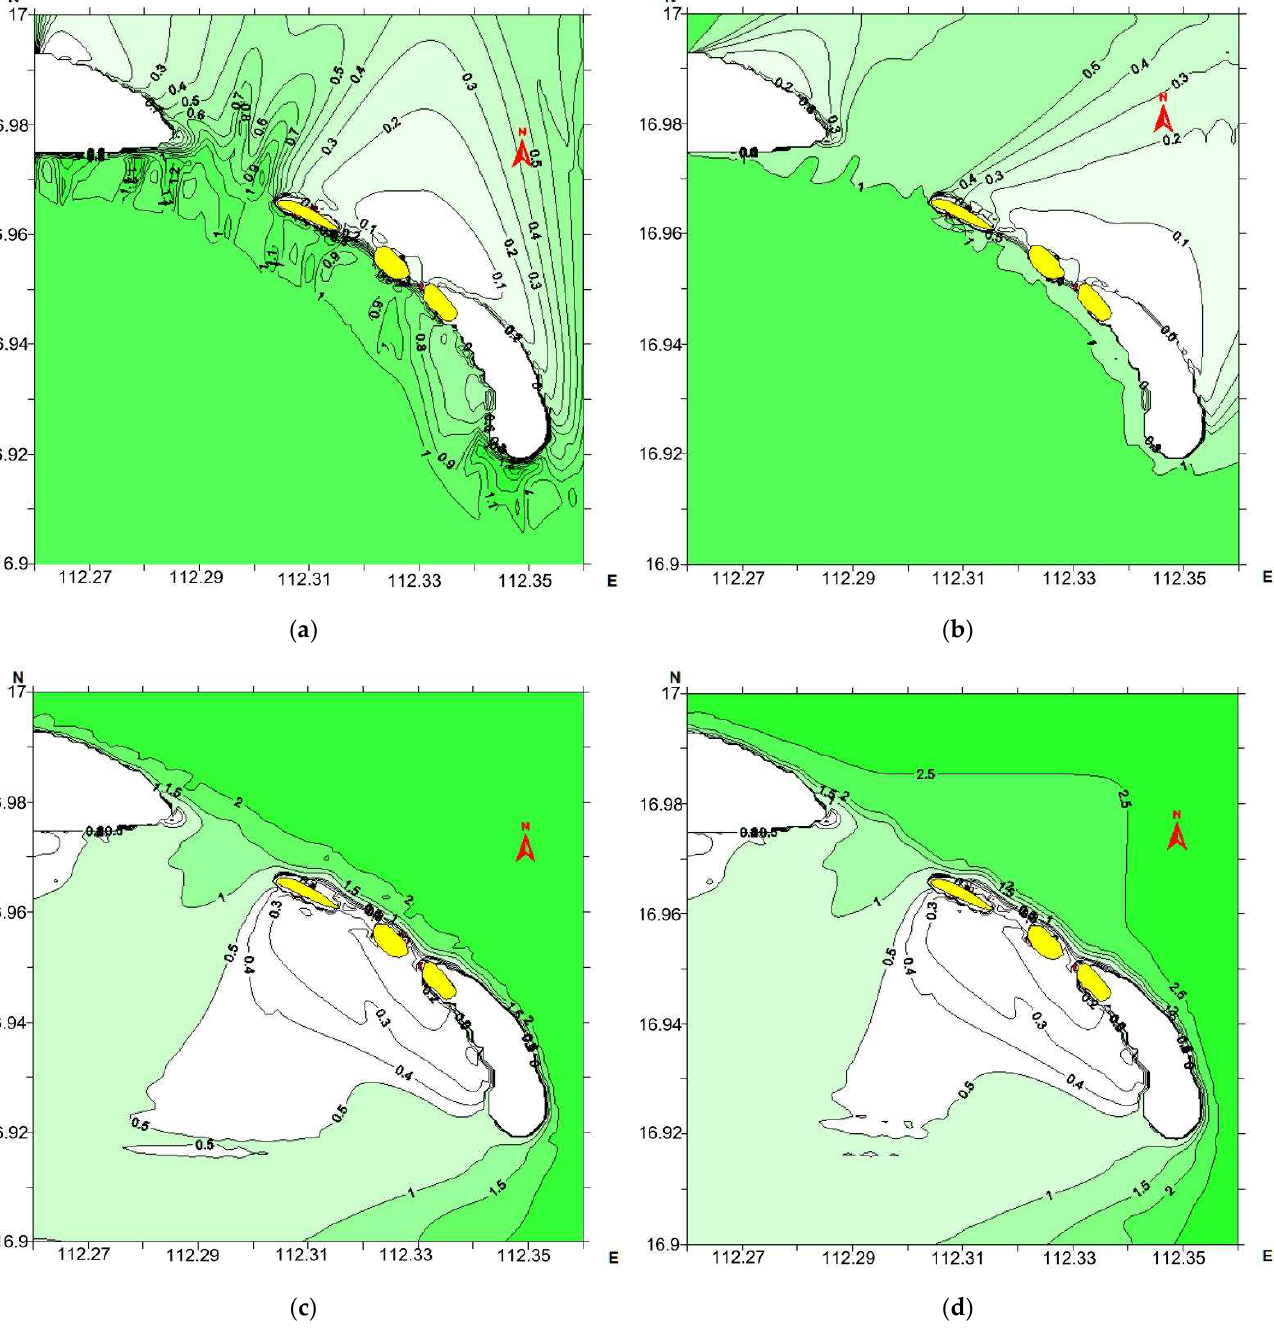
Figure 9. Seasonal variations of wave fields in islands, reefs and newborn sandbank sea areas. ( a ) Spring; ( b ) Summer; ( c ) Autumn; ( d ) Winter.